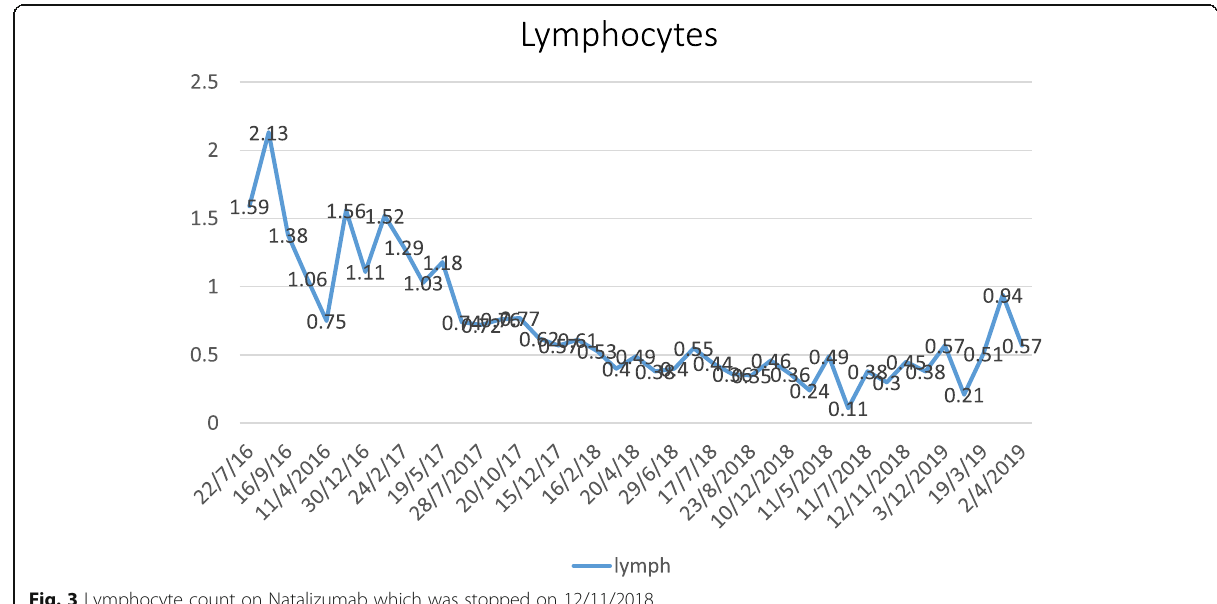
Fig. 3 Lymphocyte count on Natalizumab which was stopped on